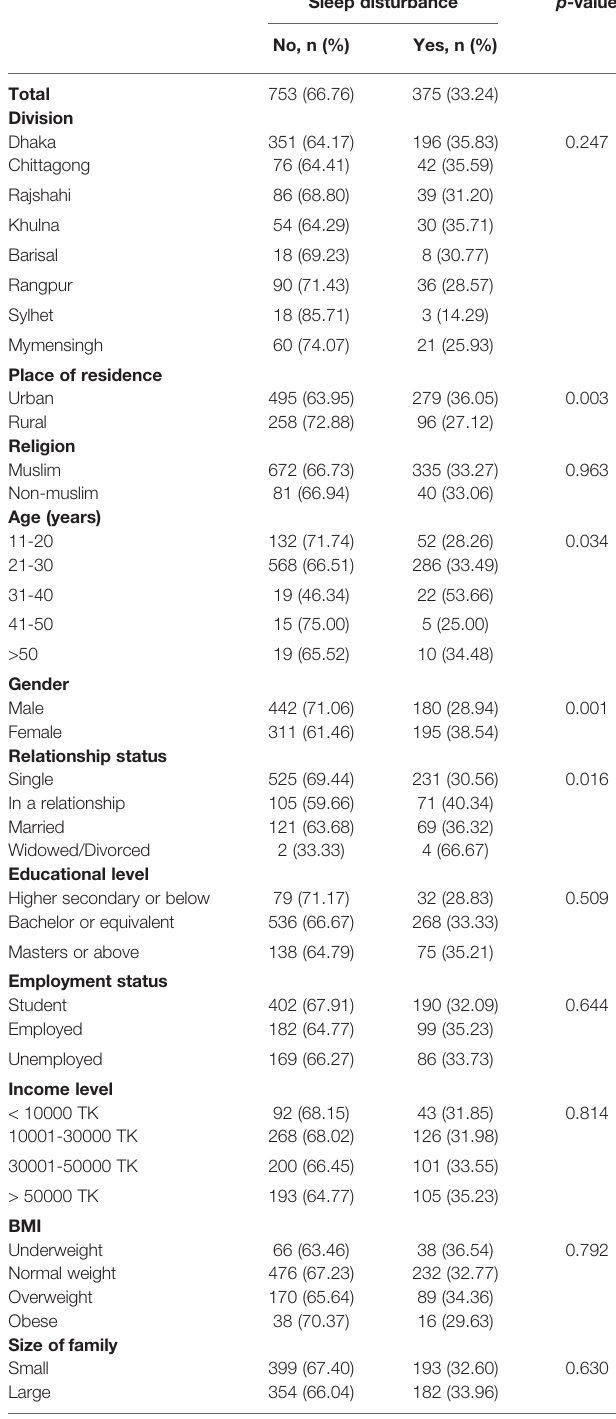
TABLE 2 | Distribution of sleep disturbance by the respondent ’ s demographic and personal characteristics. Sleep disturbance